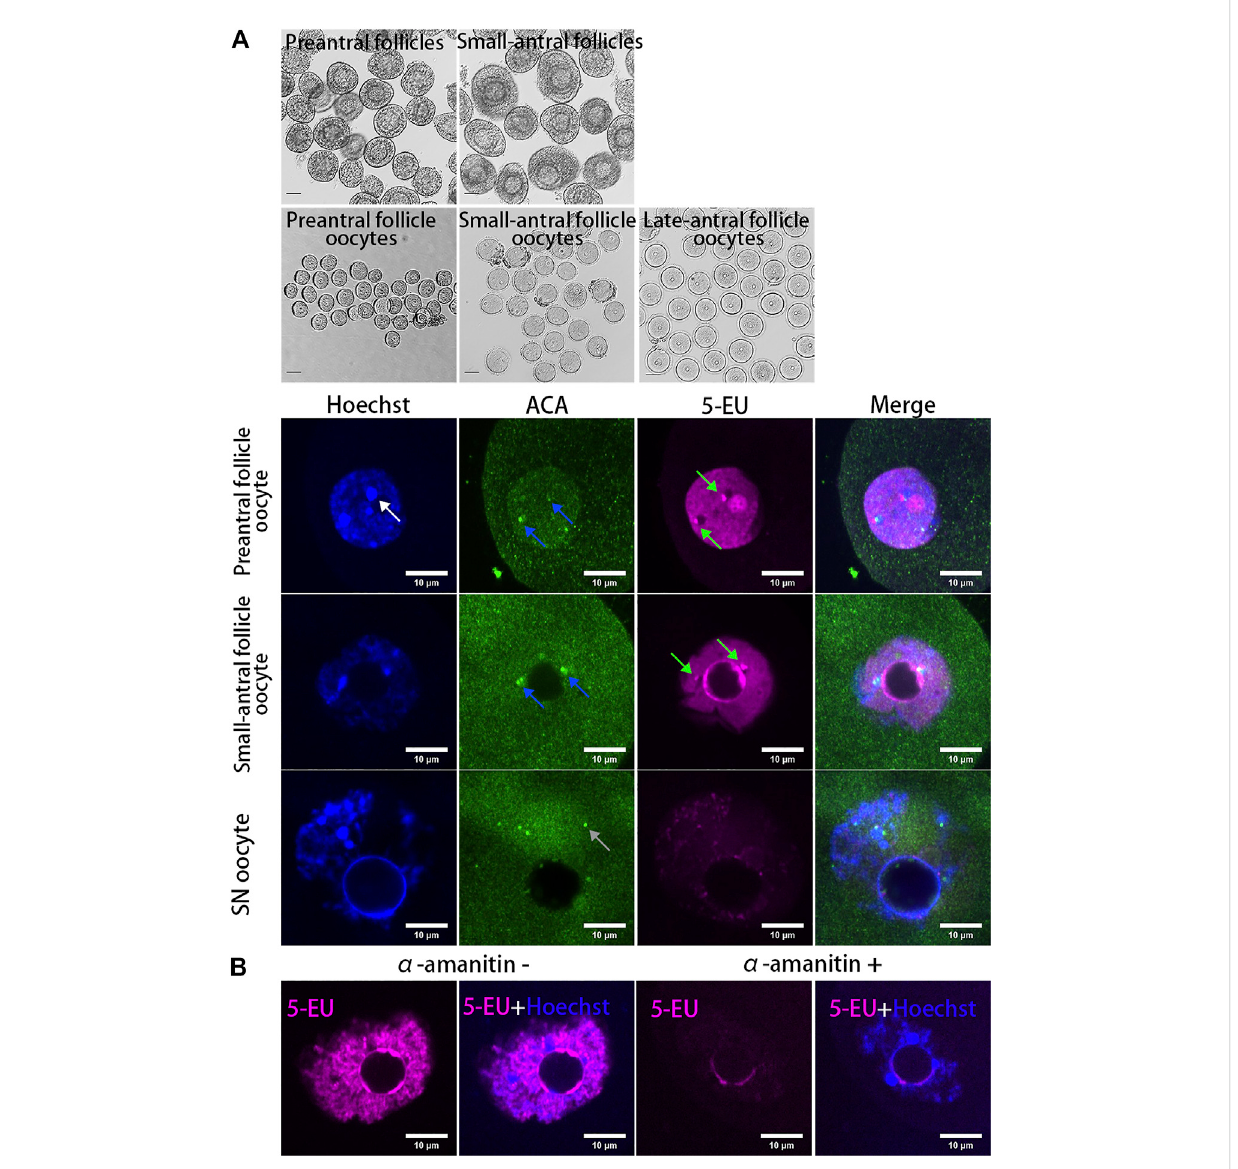
FIGURE 1 Dynamics of centromeric transcription in mouse oocytes. (A) Centromeres are transcribed in growing oocytes but not in fully grown oocytes. Oocytes isolated from preantral follicles and small-antral follicles are growing oocytes. SN oocytes are fully grown oocytes. New synthesized RNAs are marked by 5-EU (magenta). Minor centromeres are labeled by ACA antibodies (green). (B) Centromeric transcription in oocytes can be inhibited by α - amanitin. DNA are stained by Hoechst (Blue). Centromeric RNAs are indicated by green arrow. Minor satellite is indicated by blue arrow. Major satellite is indicated by white arrow. Black scale bars, 50 μ m; white scale bars 10 μ